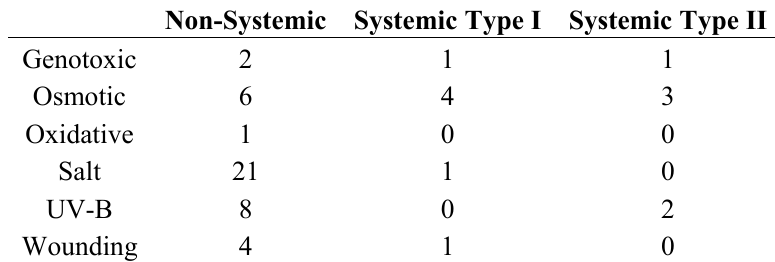
Table 2. Number of WRKY genes involved in a systemic or non-systemic abiotic stress response. The 61 WRKY genes present on the ATH1 Genechip Array are compared with all genes in each response